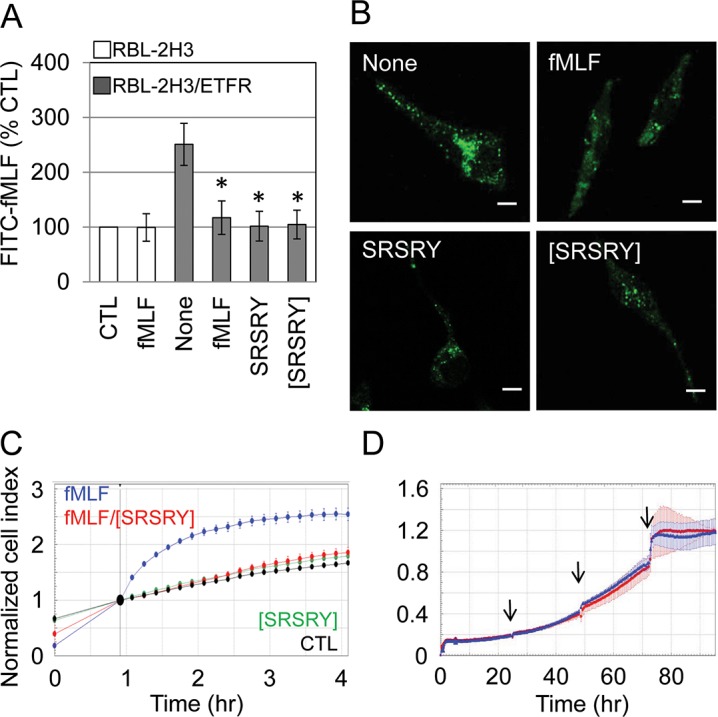
Both linear and cyclic SRSRY peptides bind to FPR1.A. RBL-2H3 or RBL-2H3/ETFR cells (1.5 x106 cells/sample) pre-incubated with diluents (None), 100 nM fMLF, 100 nM SRSRY or 100 nM [SRSRY] for 60 minutes at 4°C and then exposed to diluents or 10 nM N-formyl-Nle-Leu-Phe-Nle-Tyr-Lys-fluorescein (FITC-fMLF) for 60 minutes at 4°C. Fluorimetric measurement of cell-associated fluorescence was assed using 485 nm excitation and 535 nm emission filters. Data are expressed as a percentage of the fluorescence associated to RBL-2H3 cells exposed to FITC-fMLF alone (CTL = 100%) and represent a mean ± SD from triplicates. *Statistical significance (t-test) against None with p<0.001. B. Representative images of RBL-2H3/ETFR cells incubated with diluents (None), 100 nM fMLF, 100 nM SRSRY or 100 nM [SRSRY] for 30 minutes at 37°C and exposed to 10 nM FITC-fMLF for additional 30 minutes at 37°C. Scale bar: 5 μm. Original magnifications: 630x. C. Cell migration of RBL-2H3/ETFR cells monitored by the xCELLigence system. Cells were seeded on CIM-16-well plates and allowed to migrate toward DMEM (CTL), 10 nM [SRSRY], 10 nM fMLF or 10 nM fMLF mixed with 10 nM [SRSRY]. Cell migration was monitored in real-time for 4 hours as changes in Cell Index. Values were normalized immediately after cell addition. Data represent mean ± SD from a quadruplicate experiment. D. Cell proliferation of RBL-2H3/ETFR cells assessed by monitoring impedance by RTCA xCELLigence system. Growth medium with (red) or without 10 μM [SRSRY] (blue) was replaced every 24 hours (arrows). Data represent mean ± SD from a quadruplicate experiment.